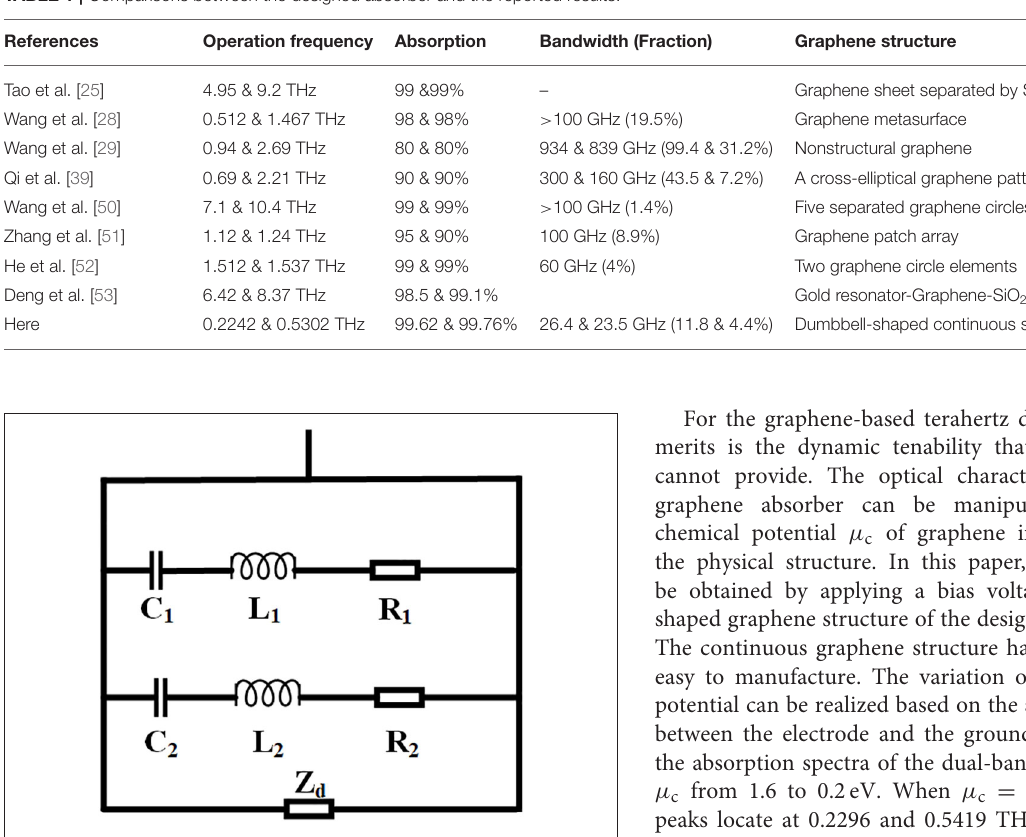
peak around 0.53 THz with d = 100 µ m doesn’t satisfy the red- shift rule. Figure 5C depicts that as the width dx increasing from 25 to 50 µ m, the resonant peak around 0.22 THz shows blue-shift, while the resonant peak around 0.53 THz is almost unchanged. As depicted in Figure 5D , when the radius r of the circles changes, the two absorption peaks are almost unchanged. Based on the above parameters analysis, the optimal geometrical parameters are concluded as follows: d = 95 µ m, dx = 35 µ m, r = 55 µ m and h_m = 50 µ